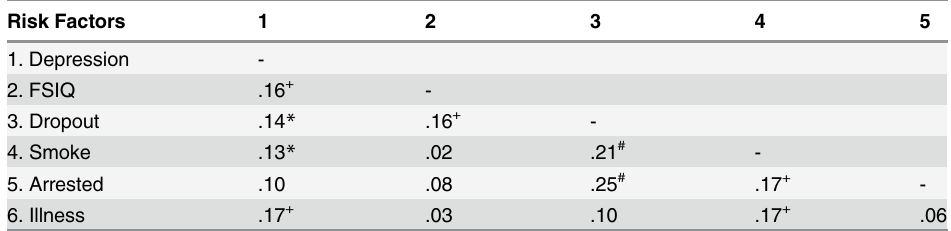
Table 2. Partial Intercorrelations among Outcome